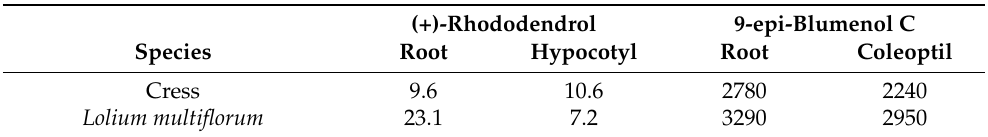
Table 2. IC 50 values ( µ M) of (+)-rhododendrol and 9- epi -blumenol C of the growth of cress and L.